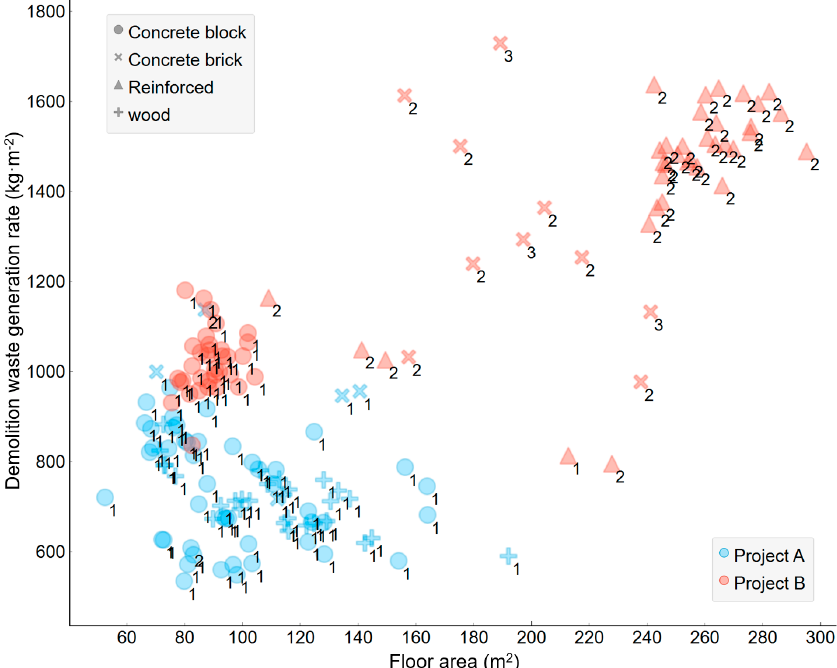
Figure 2. Scatter plot showing the distribution between the building characteristics and the DWGR (numeric labels indicate the number of floors).